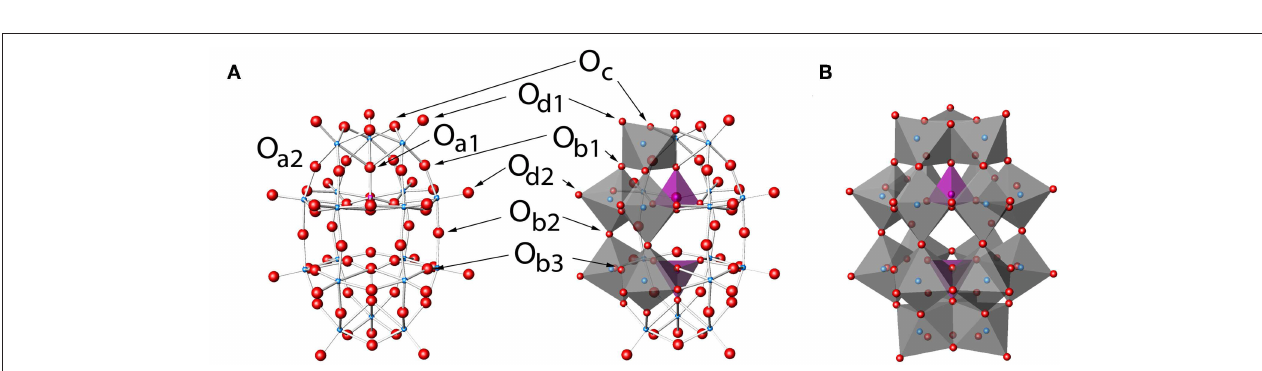
FIGURE 2 | P 2 W 18 , P 2 W 18 O 6 − 62 in (A) ball-and-stick and (B) polyhedral representations. Labels in (A) show the eight unique types of oxygen atoms and follow a modification to the naming conventions of Keggin clusters ( Janik et al., 2003). Darker and lighter polyhedra in (B) represent the cap and belt types of tungsten sites, respectively. The Wells-Dawson structure by Kato et al. (2013) with refcode RIBFUF is the structure with the lowest R 1 value reported (Kato et al., 2013) and is used in this work as a reference Wells-Dawson